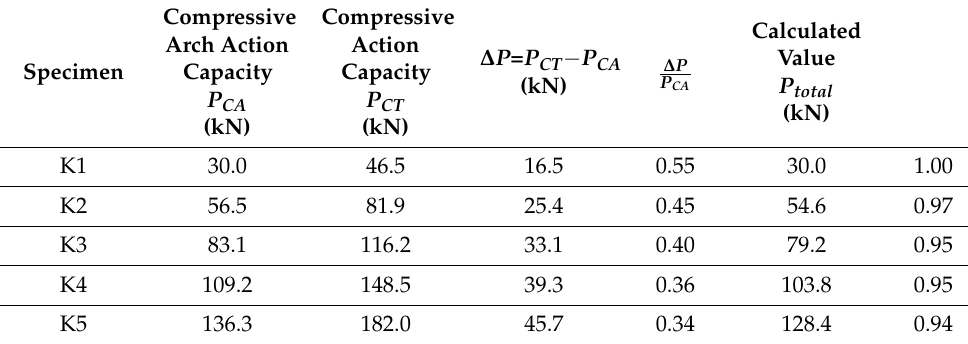
Figure 17. Load resistance of frames with different storeys. Table 1. Load capacity of frames under progressive collapse.